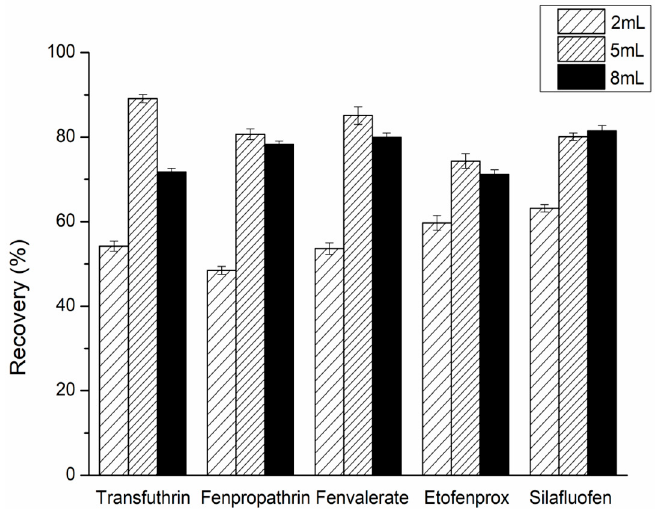
Figure 2. E ff ect of extraction solvent amount on the recoveries of five Figure 2. Effect of extraction solvent amount on the recoveries of five pyrethroids.